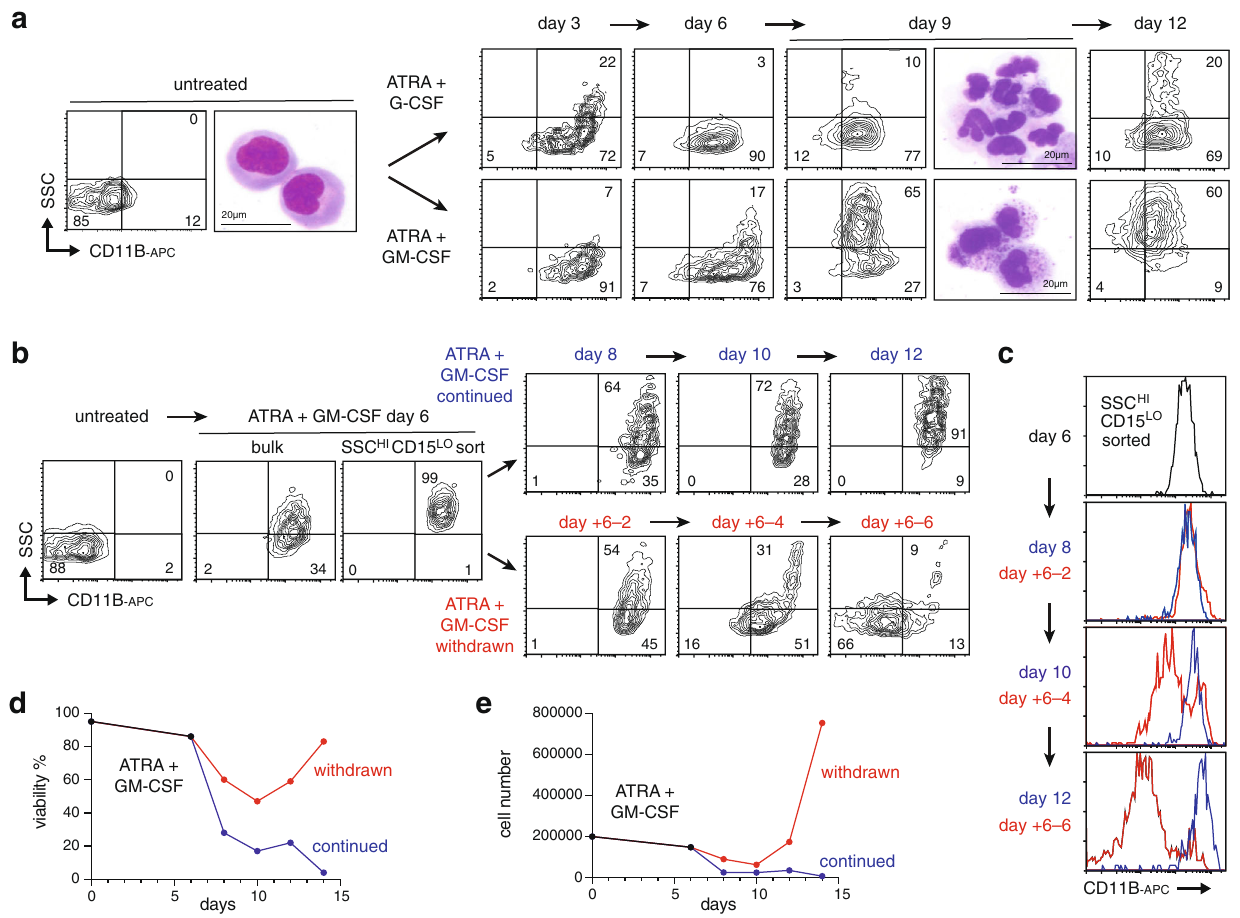
Fig. 8 De-differentiation of human AML-derived eosinophil-like cells upon therapy cessation. a SSC/CD11B pro fi les of HT93 cells during ATRA treatment combined with G-CSF (upper panels) or GM-CSF (lower panels). Representative cytospins are shown for untreated (UT) and ATRA day 9 treatments. This experiment was performed once. b SSC/CD11B pro fi les of SSC HIGH CD11B + CD15 – cells sorted from ATRA + GM-CSF cultures then either maintained on treatment (upper panels) or following ATRA/GM-CSF withdrawal (lower panels). c Surface CD11B pro fi le of cells from b , showing progressive return to an immature state following treatment withdrawal. d , e Viability ( d ) and cell count ( e ) of HT93 cells from b , showing rebound following treatment microscope. Representative images were taken with Aperio ImageScope software v11.2 (Leica).